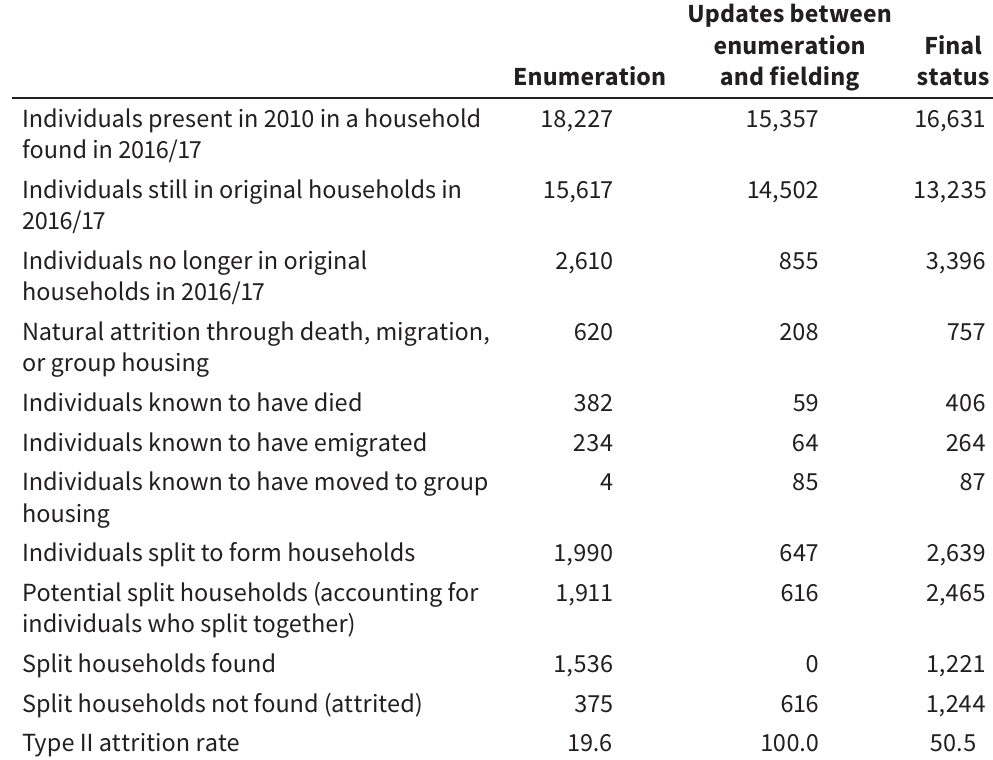
Status of individuals at enumeration and fielding